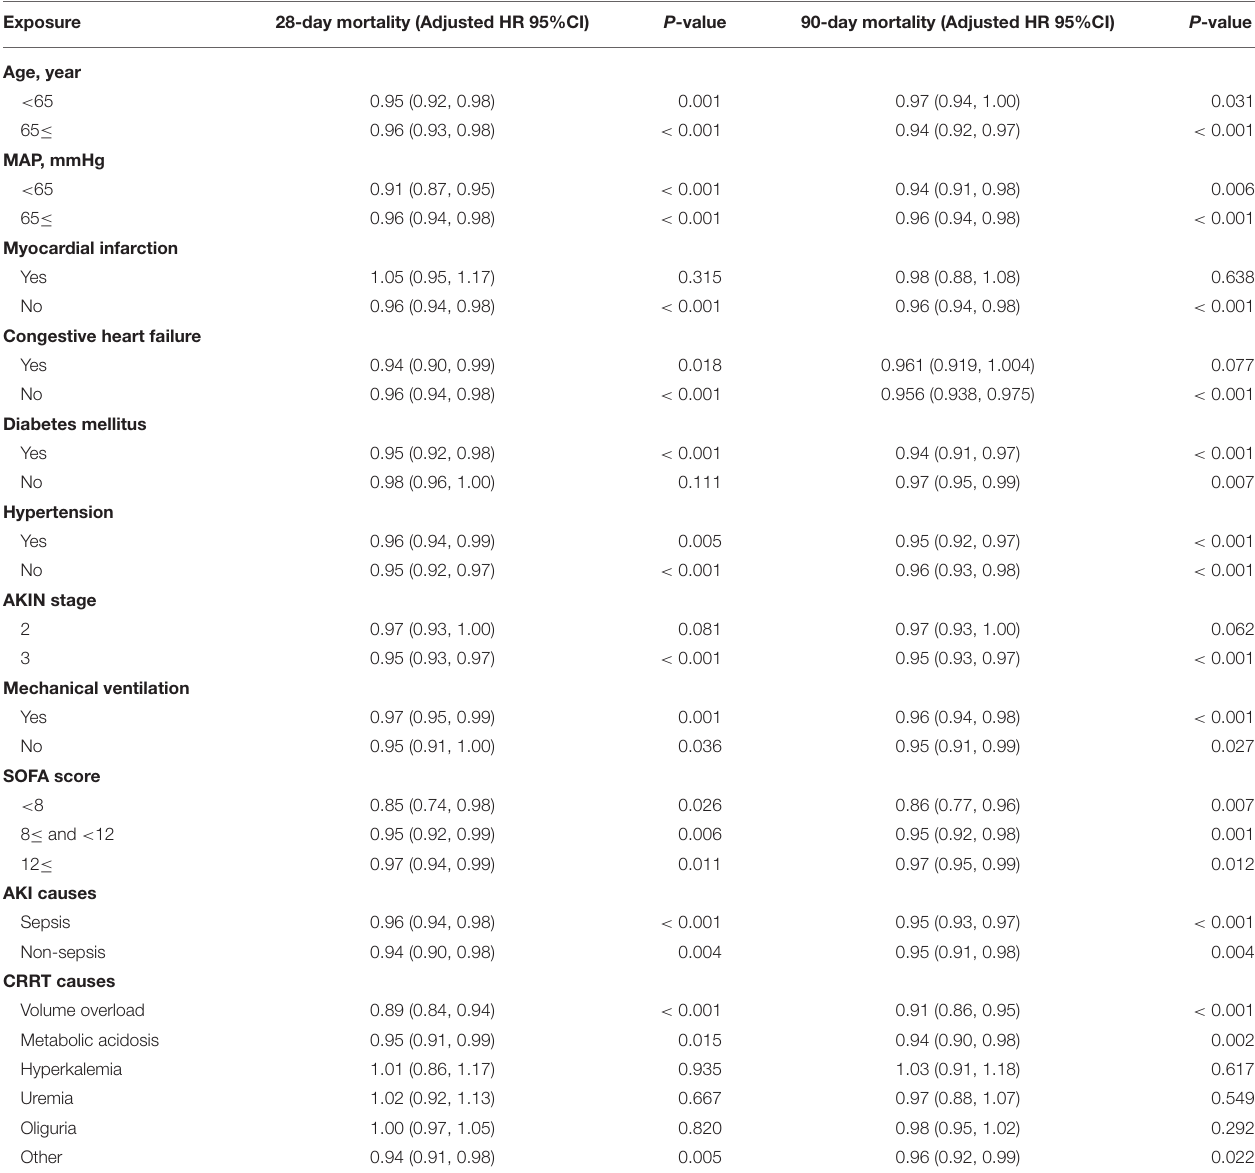
TABLE 3 | The subgroup analysis of multivariate logistic regression analysis for 28- and 90-day mortality.